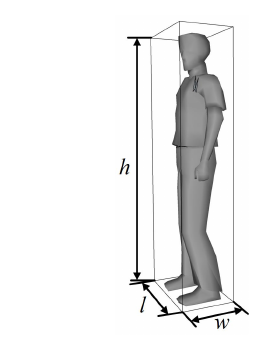
Figure 7. A pedestrian is modelled as a 3D